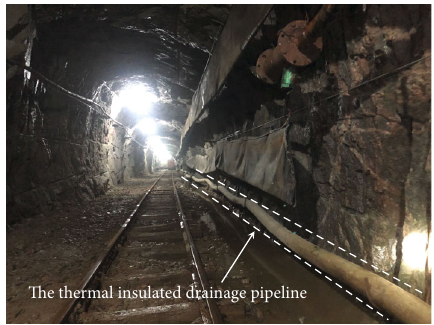
Figure 6: The water supply system.